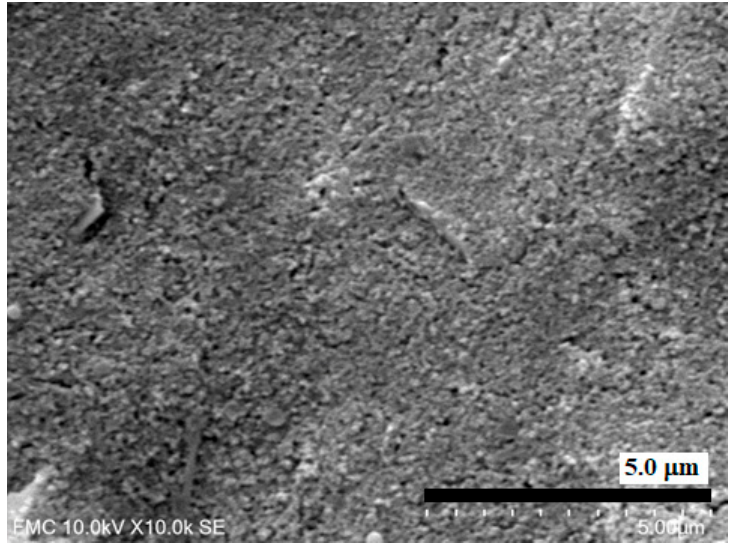
Figure 8. SEM image of the sensitive element of SPCE modified with PB.